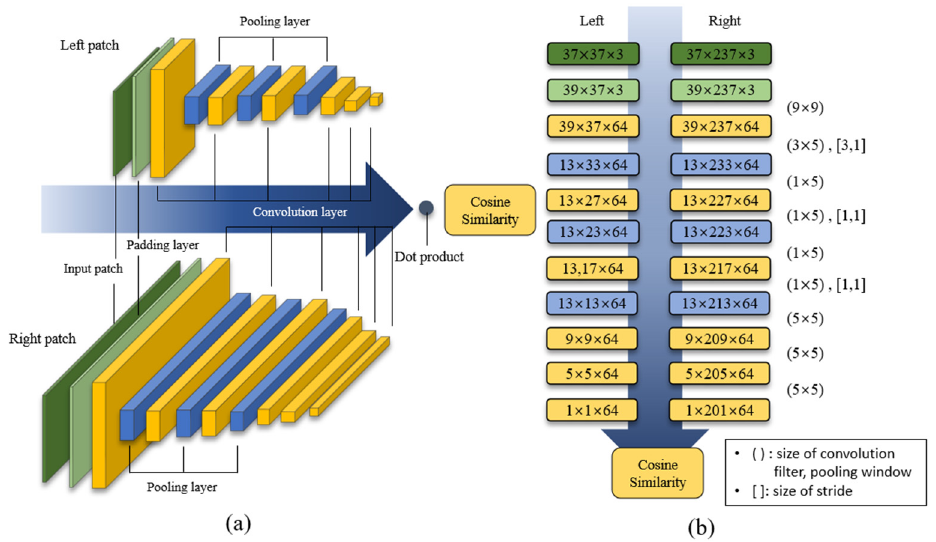
Figure 1. Network structure for extracting similarity score: ( a ) network structure composed of padding, pooling, and convolution layers; ( b ) size of each layer (height, width, channel).